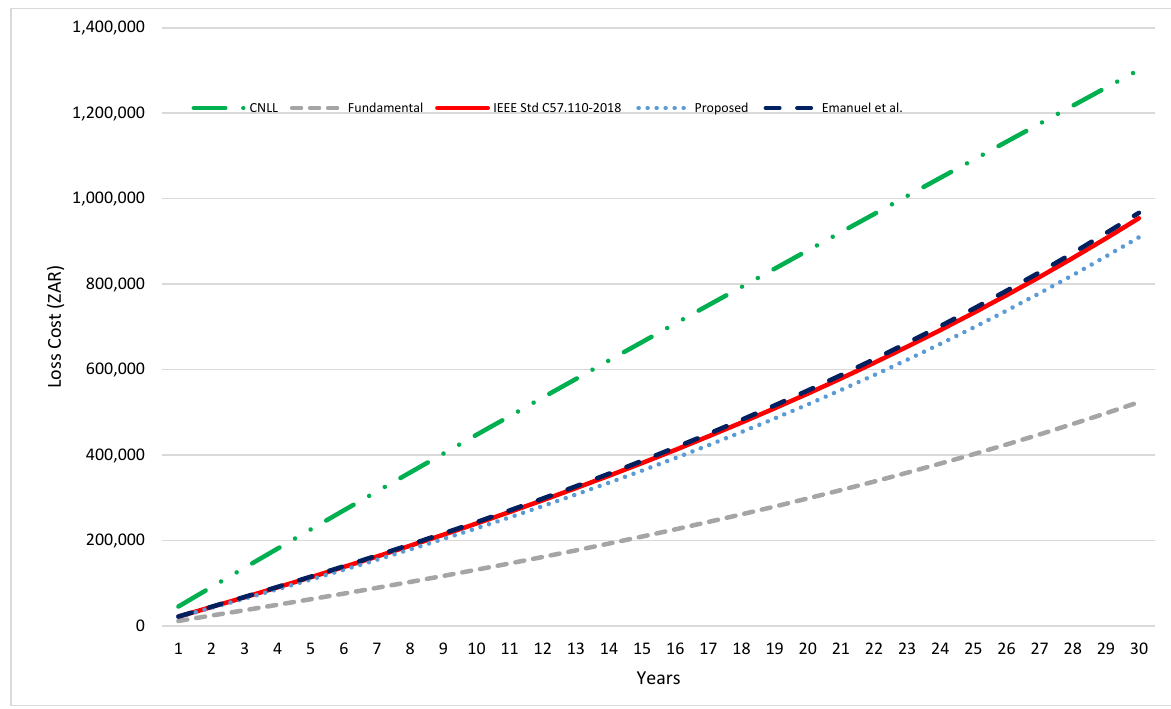
Figure 5. The influence of harmonic load current on the proposed SLEE